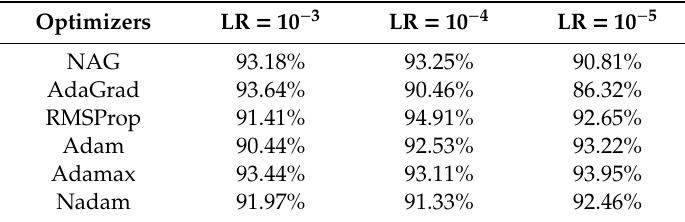
Table 3. Results obtained with the InceptionV3 architecture. Where LR stands for learning rate; NAG represents Nesterov momentum; AdaGrad represents the adaptive gradient optimizer; RMSProp represents the root mean square propagation optimizer; Adam represents adaptive moment estimation optimizer; AdaMaxrepresentsmaximumadaptivemomentestimationoptimizer; andNadamrepresents Nesterov and Adam